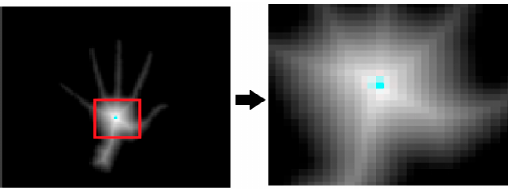
Figure 8. Image showing the hand region after applying distance transform ( left ) and the enlarged view of the region within the red rectangle ( right ).